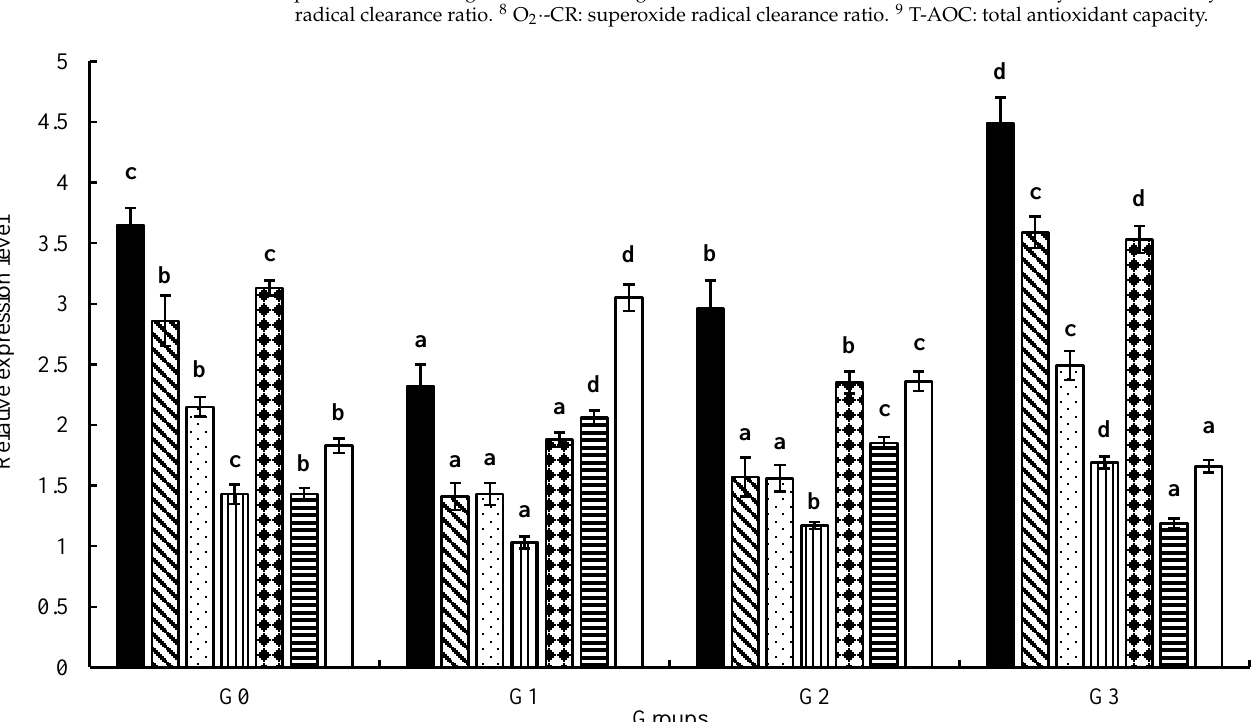
Groups Groups Figure 1. Effect of fish meal replaced by unfermented and/or fermented soybean meal on the ex- Figure 1. Effect of fish meal replaced by unfermented and/or fermented soybean meal on the Figure 1. Effect of fish meal replaced by unfermented and/or fermented soybean meal on the ex- Figure 1. Effect of fish meal replaced by unfermented and/or fermented soybean meal on the ex- Figure 1. Effect of fish meal replaced by unfermented and/or fermented soybean meal on the ex- Figure 1. Effect of fish meal replaced by unfermented and/or fermented soybean meal on the ex- pression levels of the antioxidant and immunity genes in the liver of juvenile coho salmon, in which expression levels of the antioxidant and immunity genes in the liver of juvenile coho salmon, in pression levels of the antioxidant and immunity genes in the liver of juvenile coho salmon, in which pression levels of the antioxidant and immunity genes in the liver of juvenile coho salmon, in which pression levels of the antioxidant and immunity genes in the liver of juvenile coho salmon, in which pression levels of the antioxidant and immunity genes in the liver of juvenile coho salmon, in which Figure 1. Effect of fish meal replaced by unfermented and/or fermented soybean meal on the ex- ( ■ ) indicates superoxide dismutase ( sod ), ( ) catalase ( cat ), ( ) glutathione peroxidase ( gsh-px ), ( ( ■ ) indicates superoxide dismutase ( sod ), ( ) catalase ( cat ), ( ) glutathione peroxidase ( gsh-px ), ( which ( (cid:4) ) indicates superoxide dismutase ( sod ), ( ) glutathione peroxidase ( gsh-px ), ( ■ ) indicates superoxide dismutase ( sod ), ( ) catalase ( cat ), ( ) glutathione peroxidase ( gsh-px ), ( ( ■ ) indicates superoxide dismutase ( sod ), ( ) catalase ( cat ), ( ) glutathione peroxidase ( gsh-px ), ( ( ■ ) indicates superoxide dismutase ( sod ), ( ) catalase ( cat ), ( ) glutathione peroxidase ( gsh-px ), ( pression levels of the antioxidant and immunity genes in the liver of juvenile coho salmon, in which ) glutathione S-transferase ( gst ), ( ) nuclear factor erythroid 2-related factor 2 ( nrf2 ), ( ) tumor ) glutathione S-transferase ( gst ), ( ) nuclear factor erythroid 2-related factor 2 ( nrf2 ), ( ) tumor ) glutathione S-transferase ( gst ), ( ) nuclear factor erythroid 2-related factor 2 ( nrf2 ), ( ) tumor ( ) glutathione S-transferase ( gst ), ( ) nuclear factor erythroid 2-related factor 2 ( nrf2 ), ( ) tumor ) glutathione S-transferase ( gst ), ( ) nuclear factor erythroid 2-related factor 2 ( nrf2 ), ( ) tumor ) glutathione S-transferase ( gst ), ( ) nuclear factor erythroid 2-related factor 2 ( nrf2 ), ( ) tumor ( ■ ) indicates superoxide dismutase ( sod ), ( ) catalase ( cat ), ( ) glutathione peroxidase ( gsh-px ), ( necrosis factor α ( tnf- α ), and ( □ ) interleukin-6 ( il-6 ). All above data are mean ± SD ( n = 3 × 3 × 3), and necrosis factor α ( tnf- α ), and ( (cid:3) ) interleukin-6 ( il-6 ). All above data are mean ± SD ( n = 3 × 3 × 3), ) glutathione S-transferase ( gst ), ( ) nuclear factor erythroid 2-related factor 2 ( nrf2 ), ( ) tumor necrosis factor α ( tnf- α ), and ( □ ) interleukin-6 ( il-6 ). All above data are mean ± SD ( n = 3 × 3 × 3), and necrosis factor α ( tnf- α ), and ( □ ) interleukin-6 ( il-6 ). All above data are mean ± SD ( n = 3 × 3 × 3), and necrosis factor α ( tnf- α ), and ( □ ) interleukin-6 ( il-6 ). All above data are mean ± SD ( n = 3 × 3 × 3), and necrosis factor α ( tnf- α ), and ( □ ) interleukin-6 ( il-6 ). All above data are mean ± SD ( n = 3 × 3 × 3), and different superscript letters indicate significant differences among the data ( p < 0.05). and different superscript letters indicate significant differences among the data ( p < different superscript letters indicate significant differences among the data ( p < 0.05). different superscript letters indicate significant differences among the data ( p < 0.05). different superscript letters indicate significant differences among the data ( p < 0.05). different superscript letters indicate significant differences among the data ( p < 0.05). necrosis factor α ( tnf- α ), and ( □ ) interleukin-6 ( il-6 ). All above data are mean ± SD ( n = 3 × 3 × 3), and different superscript letters indicate significant differences among the data ( p < 0.05).